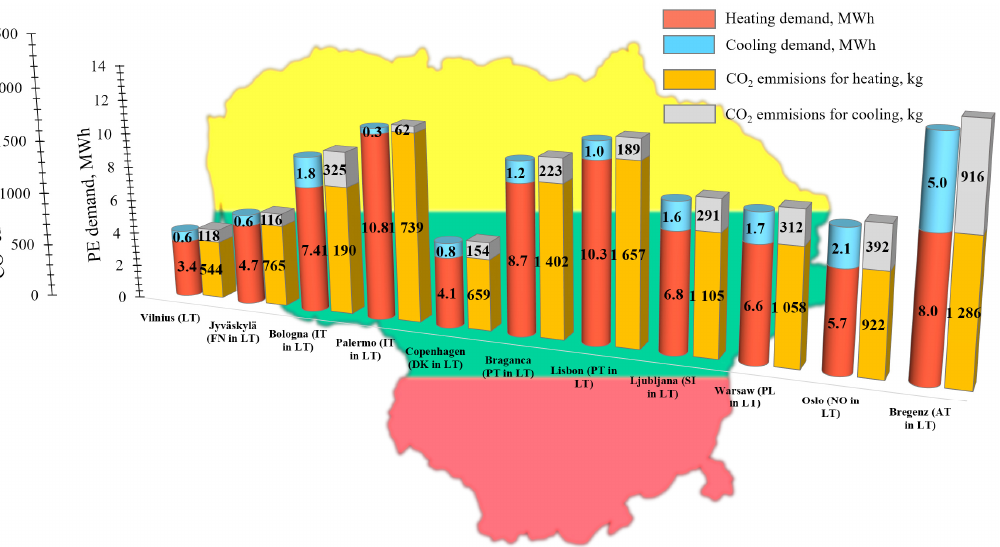
Figure 9. The aggregate primary energy demand for heating and cooling (MWh) in a building and the aggregate carbon dioxide emissions for heating and cooling (kg) in Lithuanian climatic conditions.